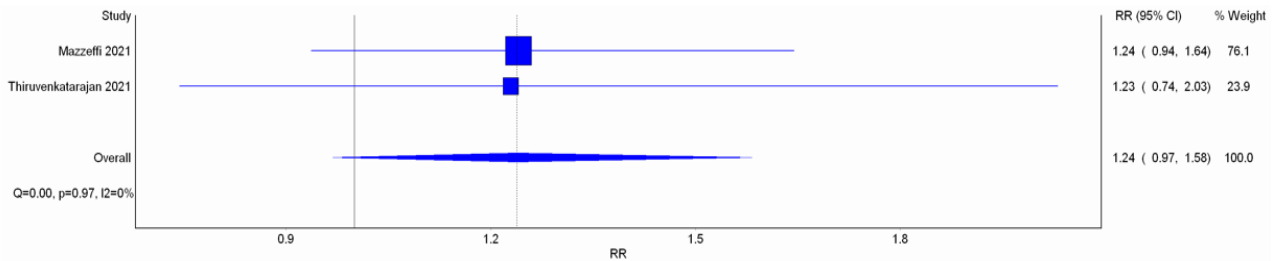
Figure A8. Bayesian random effect consistency model Outcome: Need for minor airway interven- tions.